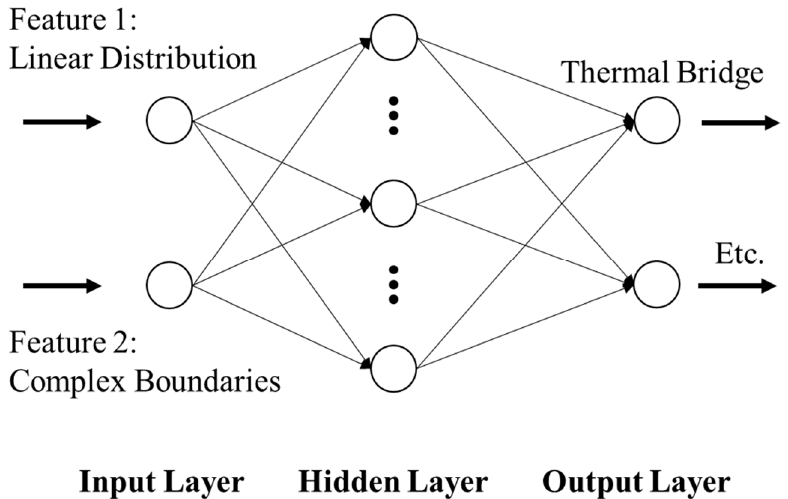
Figure 6. Structure of a neural network.